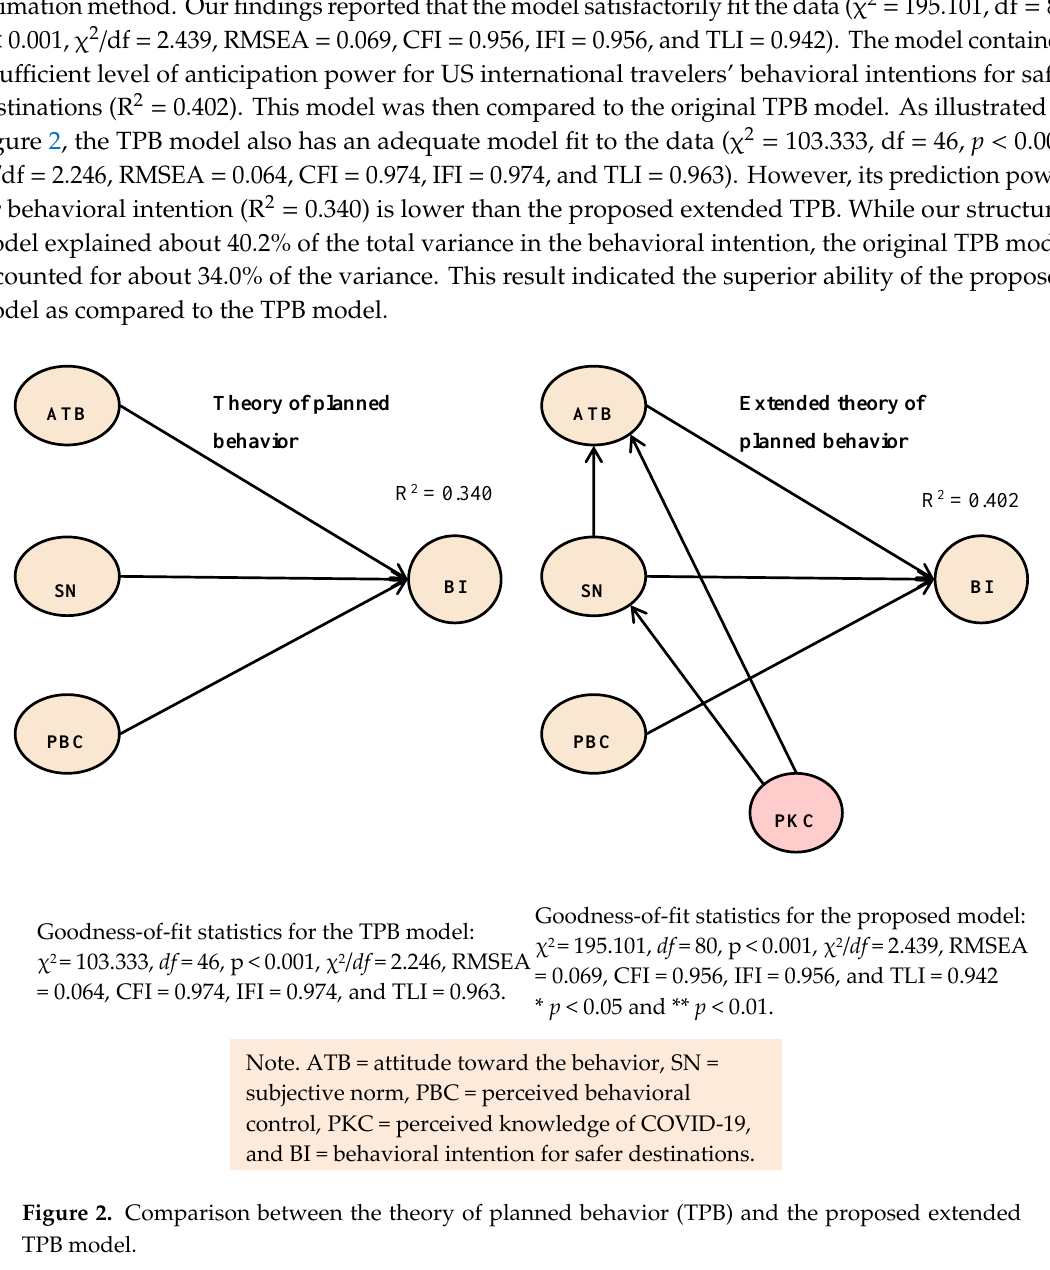
Figure 2. Comparison between the theory of planned behavior (TPB) and the proposed extended TPB model.